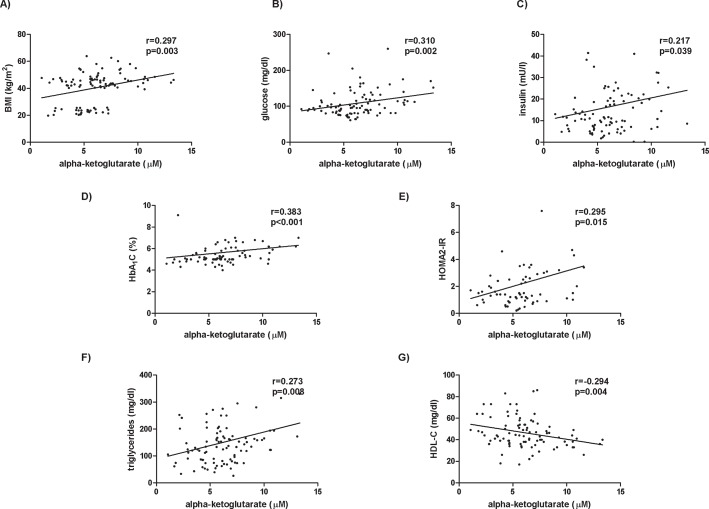
Significant correlations between alpha-ketoglutarate levels and anthropometrical and biochemical variables.The strength of association between variables was calculated using Spearman’s r correlation test. BMI, body mass index; HbA1c, glycosylated hemoglobin; HOMA2-IR, homeostatic model assessment method-insulin resistance, HDL-C, high density lipoprotein cholesterol.